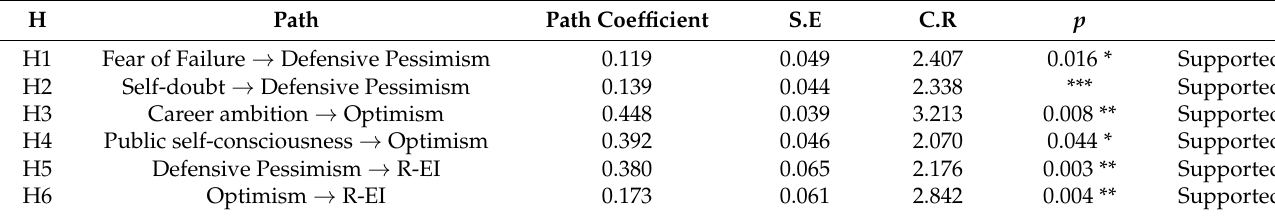
Table 5. Results of the path